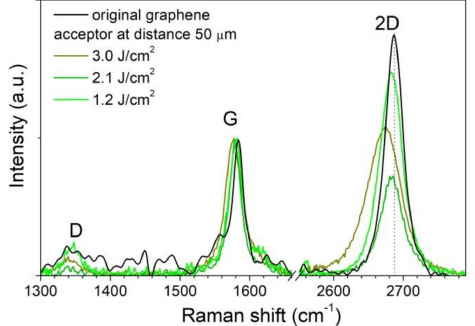
Figure 3. Raman spectra of the graphene films, recorded from the initial film on the donor substrate and areas on the acceptor substrate placed at a distance of 50 µ m from the